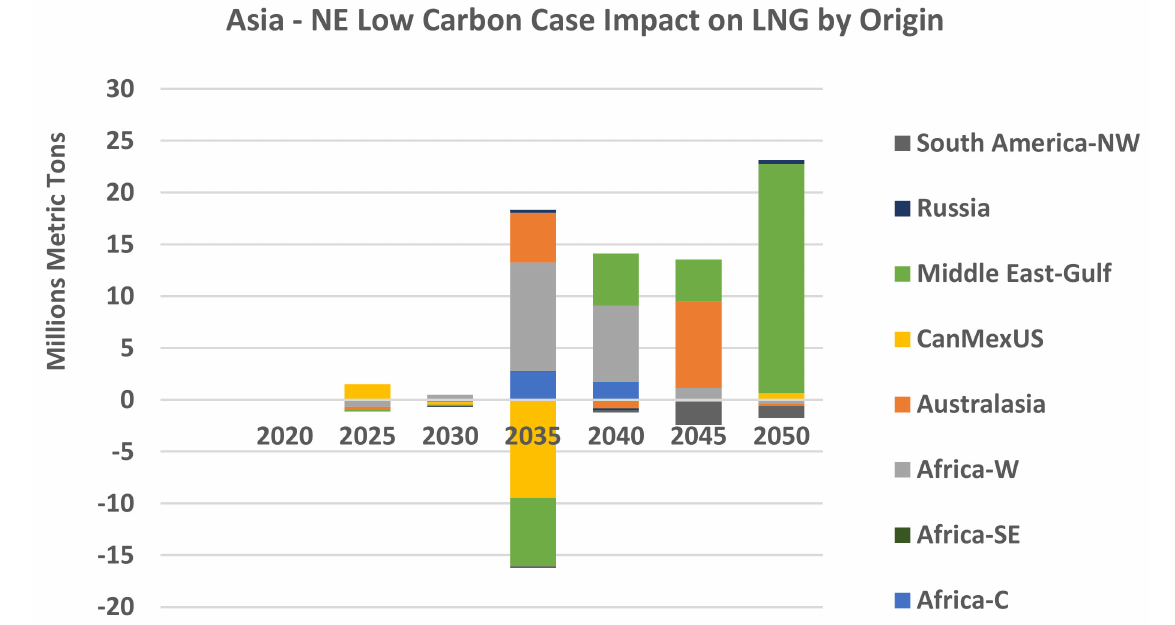
Figure 28. NE Asia net LNG impact by origin in. low-carbon case compared to base.